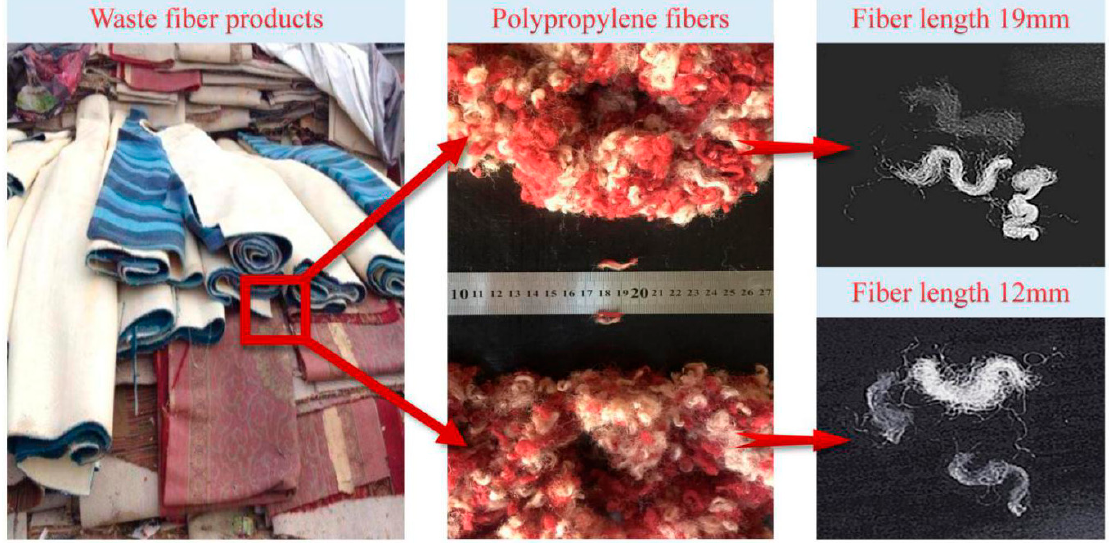
Figure 3. Waste polypropylene fibers.